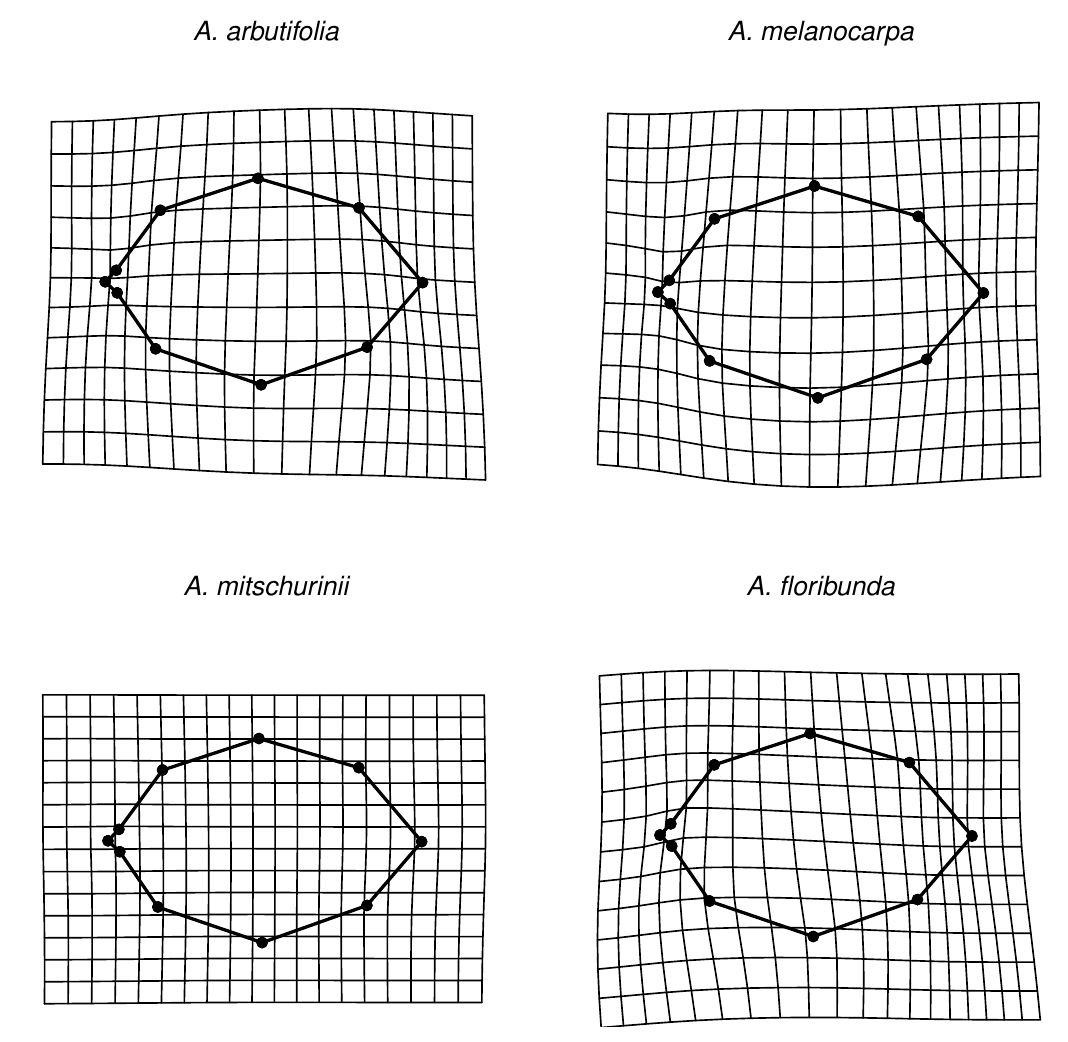
Fig. 7. Transformation grids of leaf shape from four Aronia species, with deformations required to reach the overall average